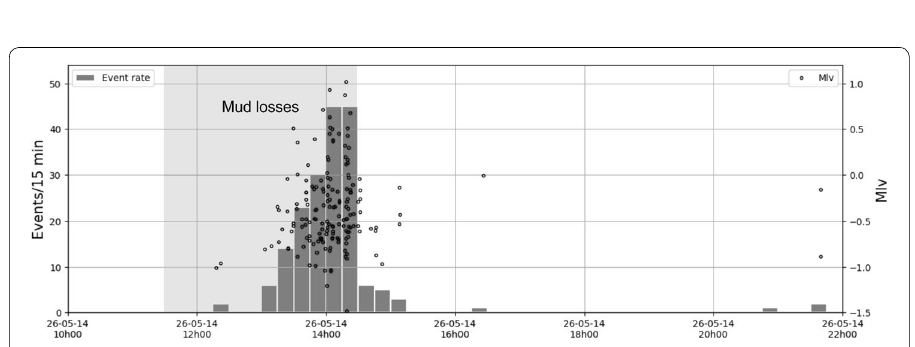
Fig. 7 GRT-2 drilling. Seismic rate, per 15 min, and local magnitudes of the recorded